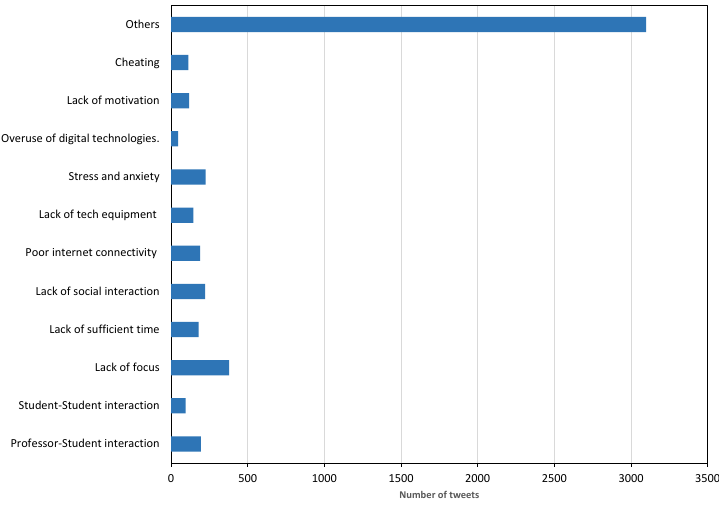
Figure 4. Number of tweets in each